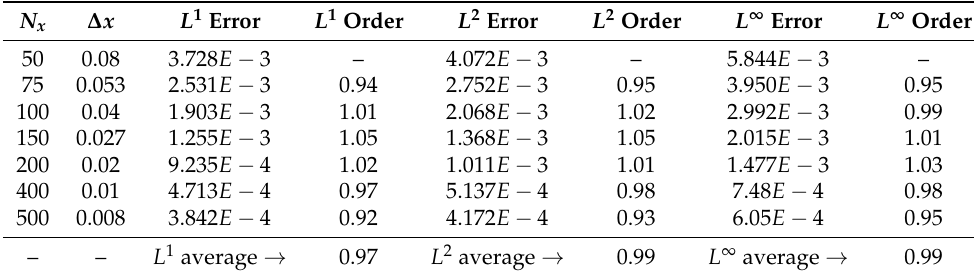
Table 1. Stefan problem with configuration ρ l (cid:54) = ρ s with fixed time step ∆ t = 10 − 4 —Error and order of convergence in L 1 , L 2 and L ∞ norms— ∆ x space step varying between 0.08 and 0.008.